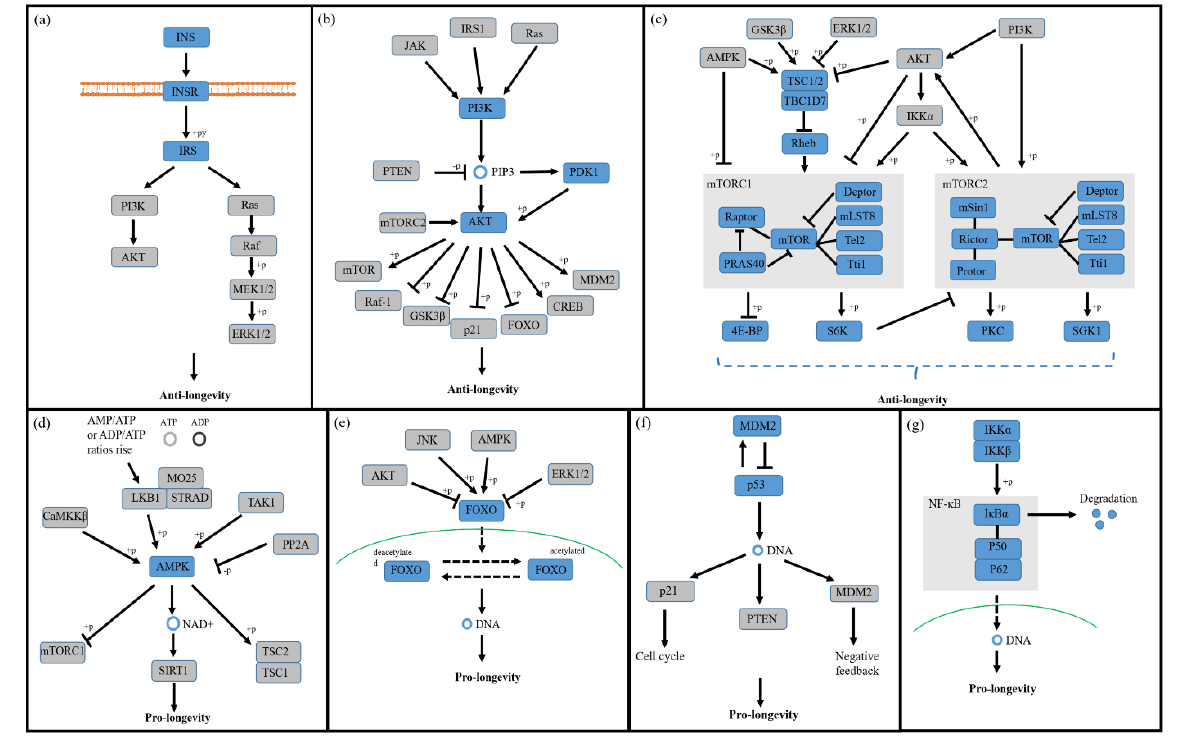
Figure 2. Signal transduction through seven age − related signaling pathways. ( a ) IIS signaling pathway; ( b ) PI3K − AKT signaling pathway; ( c ) mTOR signaling pathway; ( d ) AMPK signaling pathway; ( e ) FOXO signaling pathway; ( f ) p53 signaling pathway; ( g ) NF −κB signaling pathway. The blue squares indicate the core factors in each pathway, while the gray squares indicate the upstream or downstream targets.